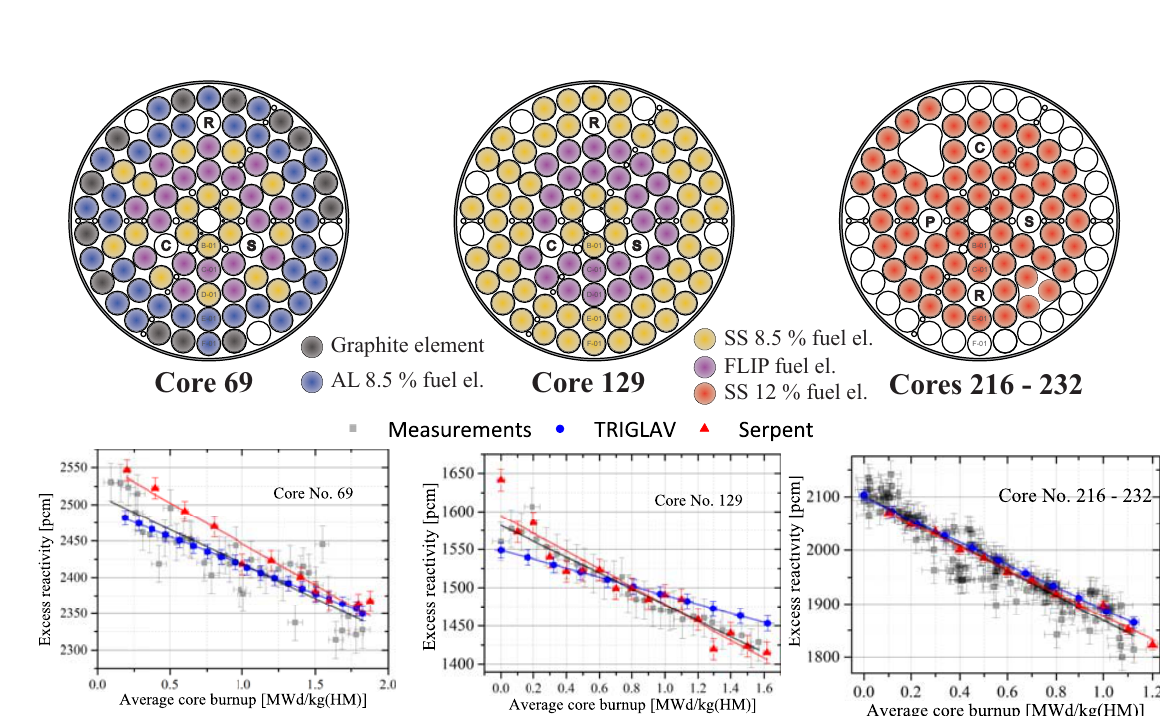
Figure 6: TRIGA core excess reactivity (bottom) as a function of average core burnup for three different core configurations (top). For each core measurements are compared to Serpent-2 and TRIGLAV burnup calculations. It should be noted that the presented graphs represent only 3 out of 46 analysed cycle excess reactivity changes. Core configurations 216 - 232 represent multiple identical loading